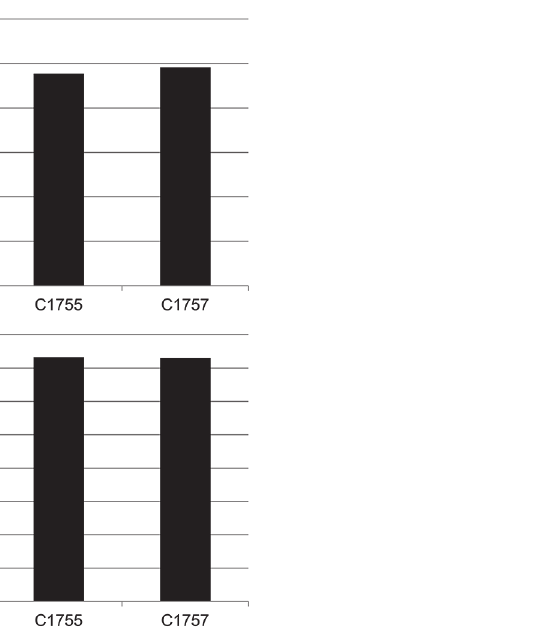
Fig 4. Relative abundance of integronase genes (A) and plasmids